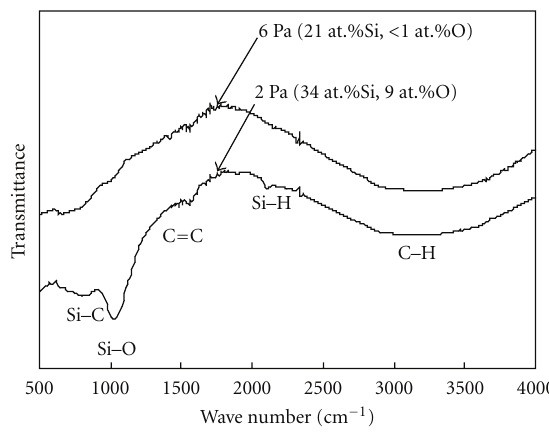
Figure 1: FT-IR spectra of DLC-Si–O